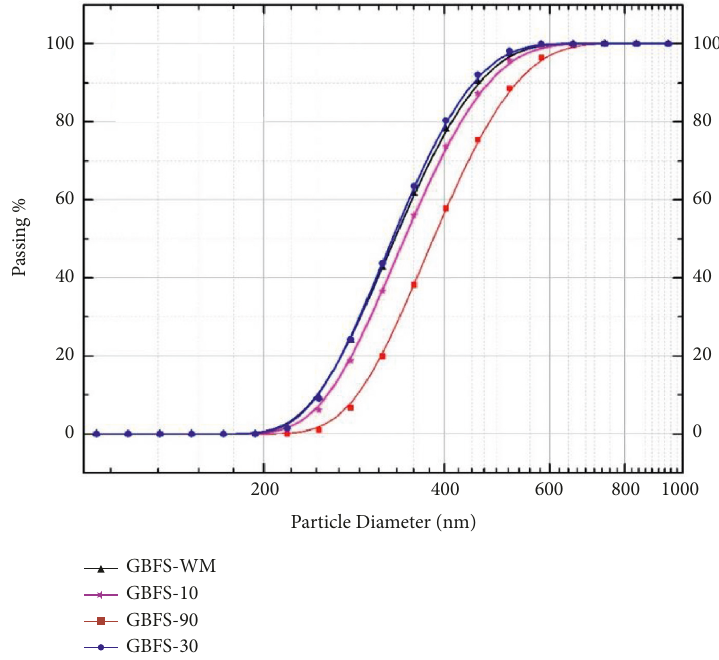
Figure 7: Particle size analysis of